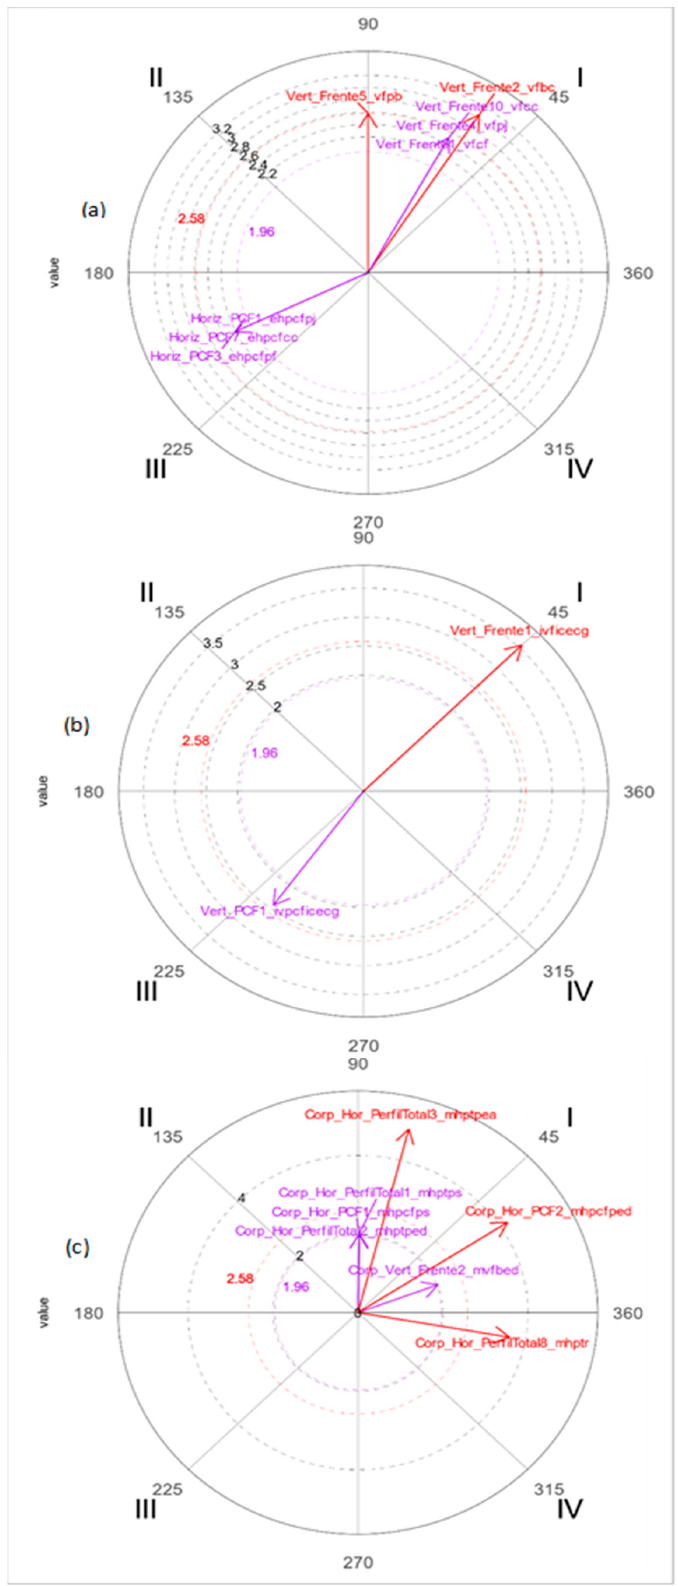
Figure 2. Polar coordinate maps of the character with the highest number of significant vectors in the representation of movement in the drawings at 6 years. ( a ) Macrocategory static -wolf; ( b ) macrocategory indication -rabbit; ( c ) macrocategory movement -wolf.